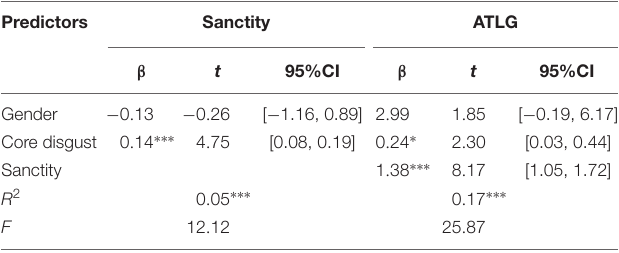
TABLE 4 | Individual associations between variables in the mediation model, where sanctity was hypothesized to mediate the association between core disgust and ATLG ( N = 452).